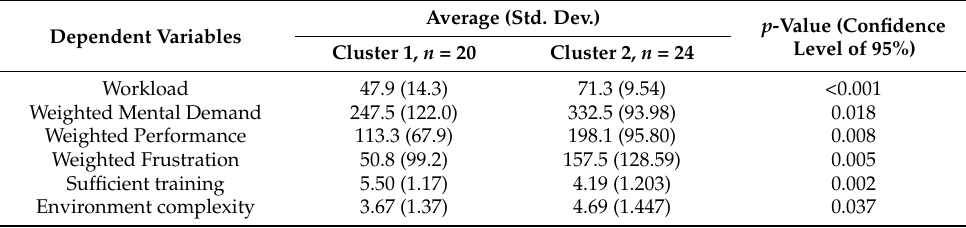
Table 5. Averages of the participants’ performance per group and the result of the significance test. Dependent